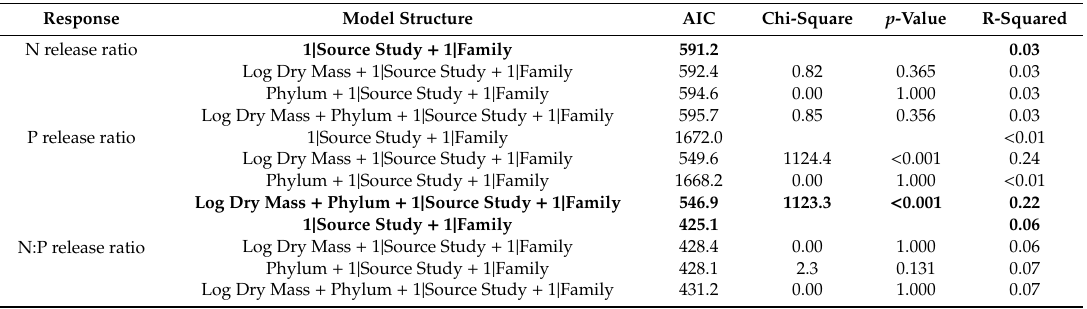
Table 2. Summary of weighted mixed e ff ects models predicting nitrogen (N), phosphorus (P), and N:P release ratios of egestion compared dissolved inorganic N (DIN), dissolved inorganic P (DIP), and DIN:DIP excretion across animals. Boldface indicates best-fit models based on lowest Akaike Information Criteria (AIC) scores. See Table S1 for model